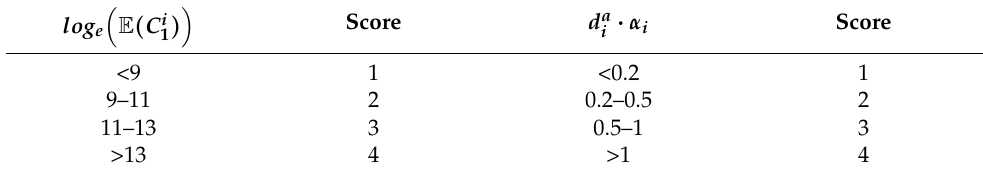
Table A5. Severity (left side) and likelihood (right side) scores definition.